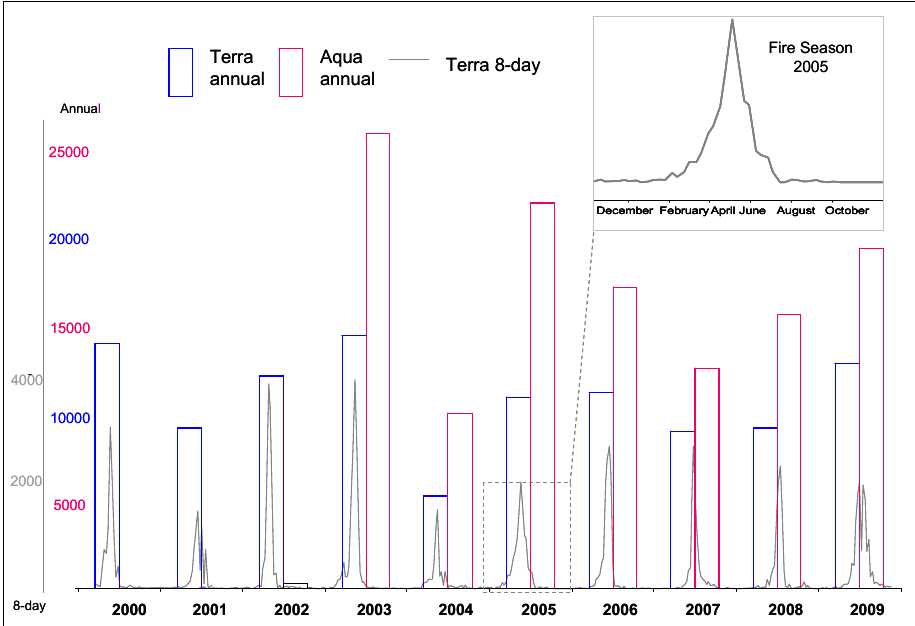
Figure 4. Cumulative annual and 8-day frequency (counts) of fire occurrence (FIRE), 2000–2009 in the three-state Yucatán Peninsula: blue = morning purple = afternoon. Inset shows detail of intra-annual fire season for 2005.